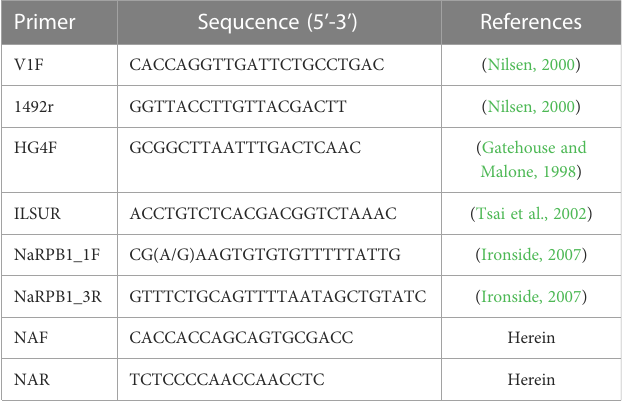
TABLE 1 The primers used for amplifying and sequencing microsporidia rDNA and Rpb1.